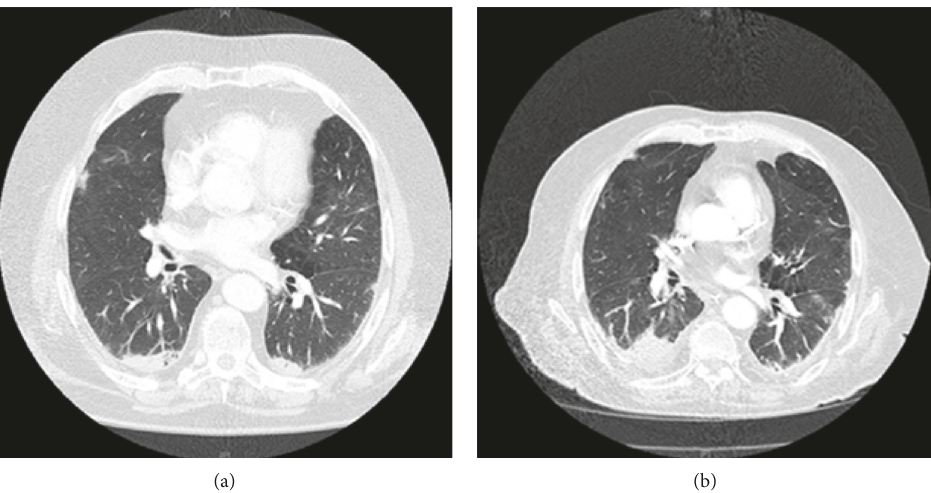
Figure 3: (a) CTpulmonary angiogram of patient 2 reveals bilateral calcified pleural plaques, subpleural fibrosis, paraseptal emphysematous change, and a small region of honey combing in the right lower lobe base laterally. (b) CTchest six months later revealing interval increase in the size of the consolidation, resolution of the right upper lobe spiculated lesions, and stable pulmonary fibrosis.